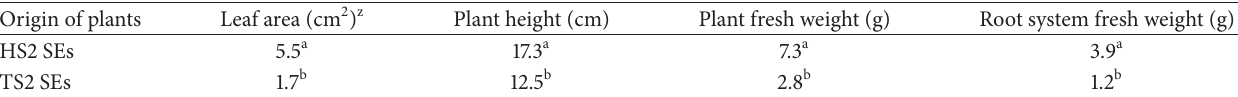
Table 3: Comparison between plants obtained from HS2 and TS2 SEs after transplantation for 6 months in a simple shed covered with a 50% sunshade net.